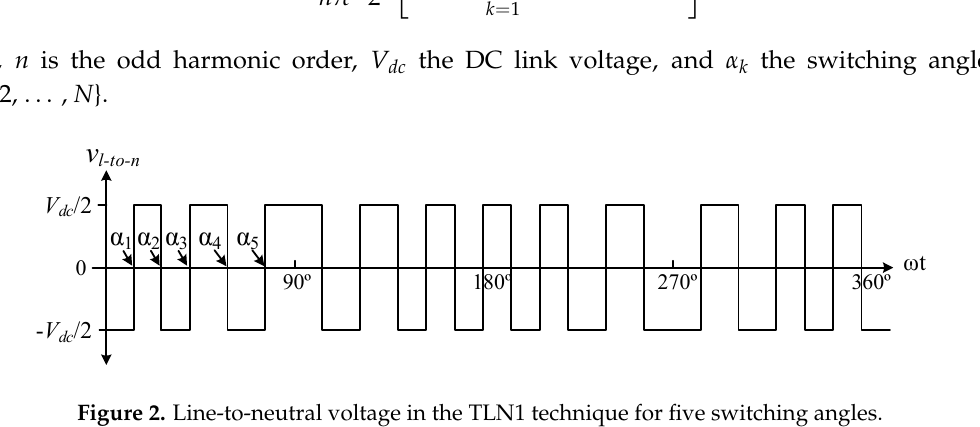
Figure 2. Line ‐ to ‐ neutral voltage in the TLN1 technique for five switching angles. Figure 2. Line-to-neutral voltage in the TLN1 technique for five switching